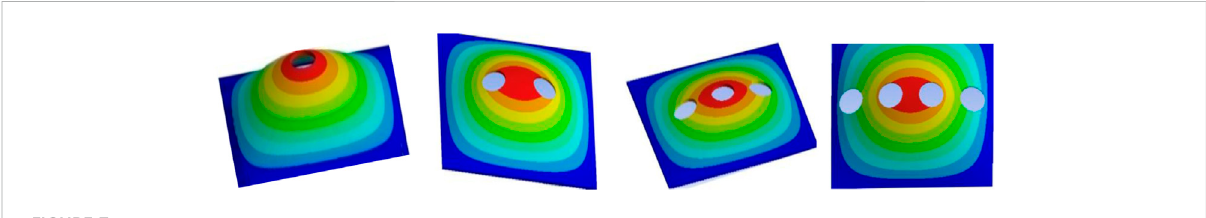
FIGURE 7 First modal vibration mode shapes for the perforated square plates.